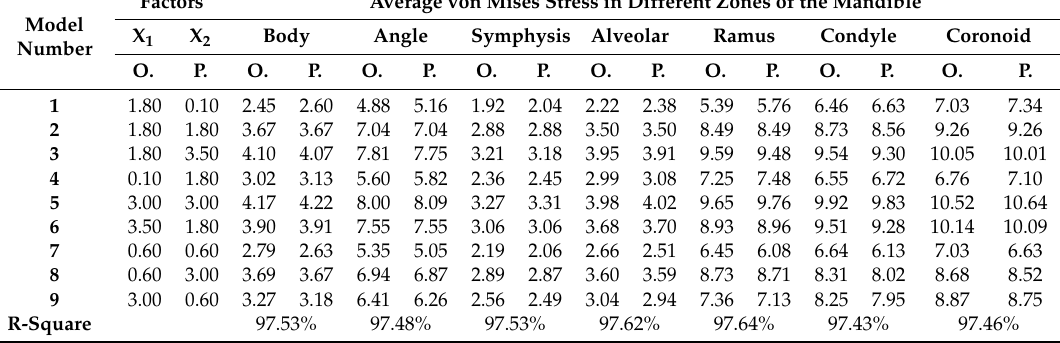
Table 7. Predicted and observed values obtained from RSM technique (X 1 = Inferior wires diameter, X 2 = Superior wires diameter, O = Observe, i.e., calculated with Finite Element Analysis (FEA), P = Predicted, i.e., calculated by